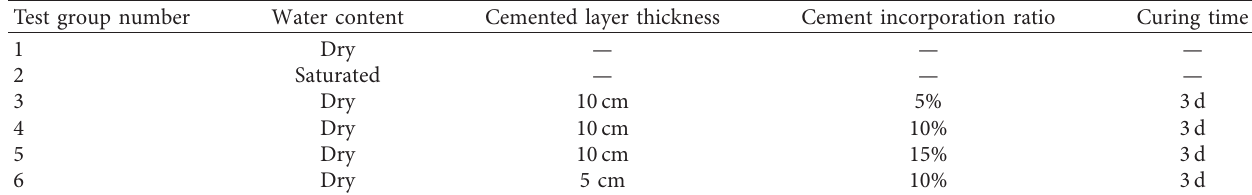
Table 4: Experiment scheme of PLTs.